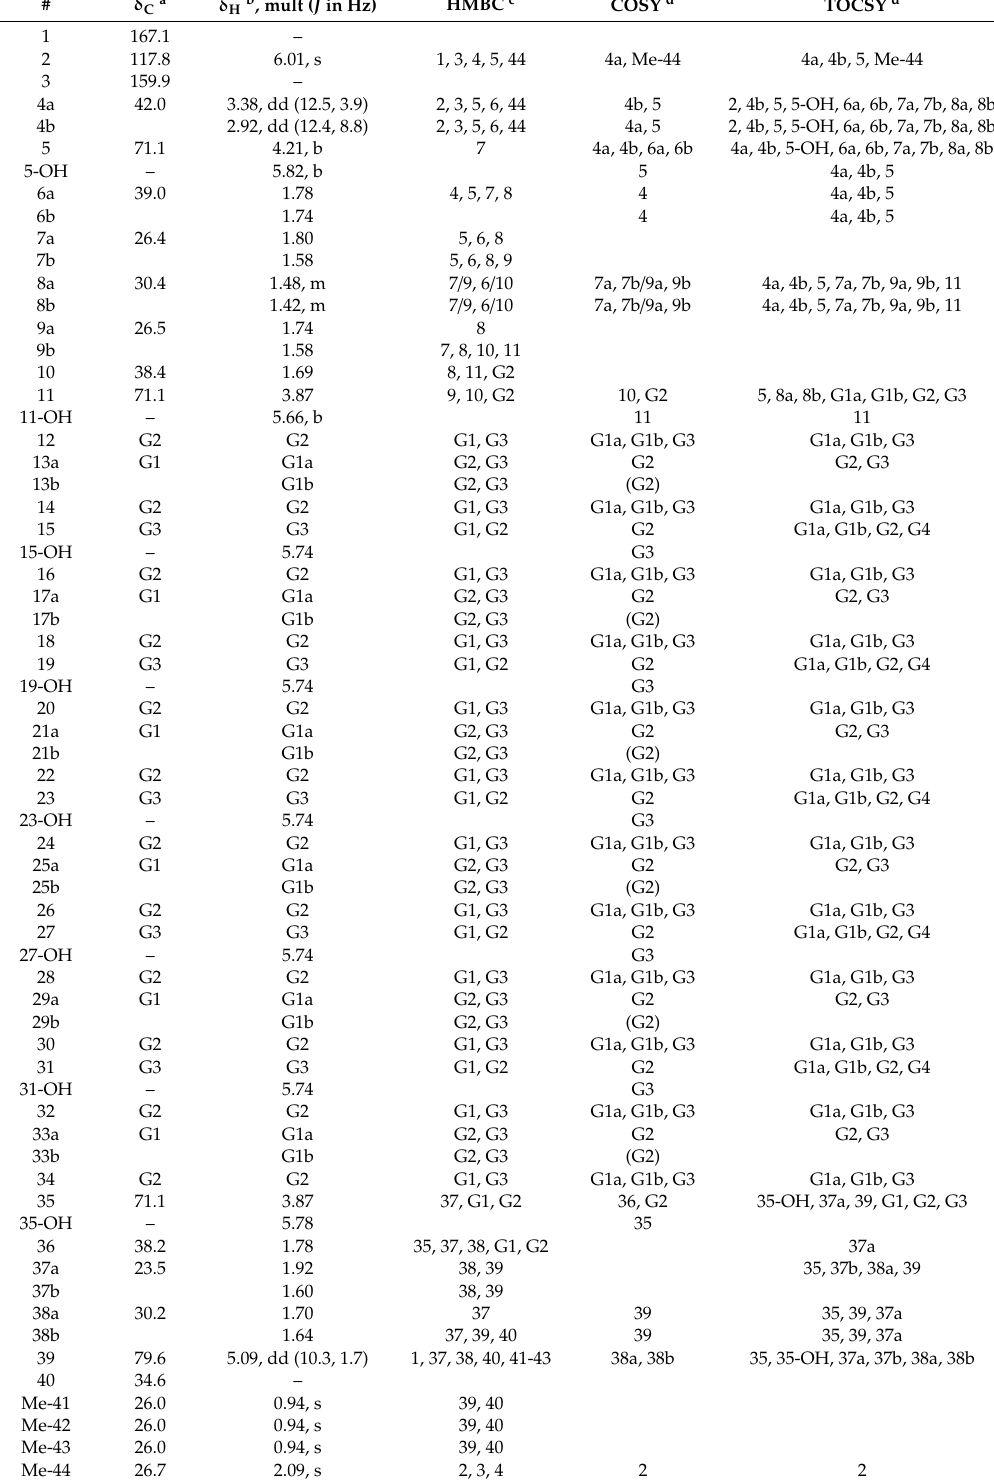
Table 1. NMR spectroscopic data for palstimolide A ( 1 ) in pyridine- d 5